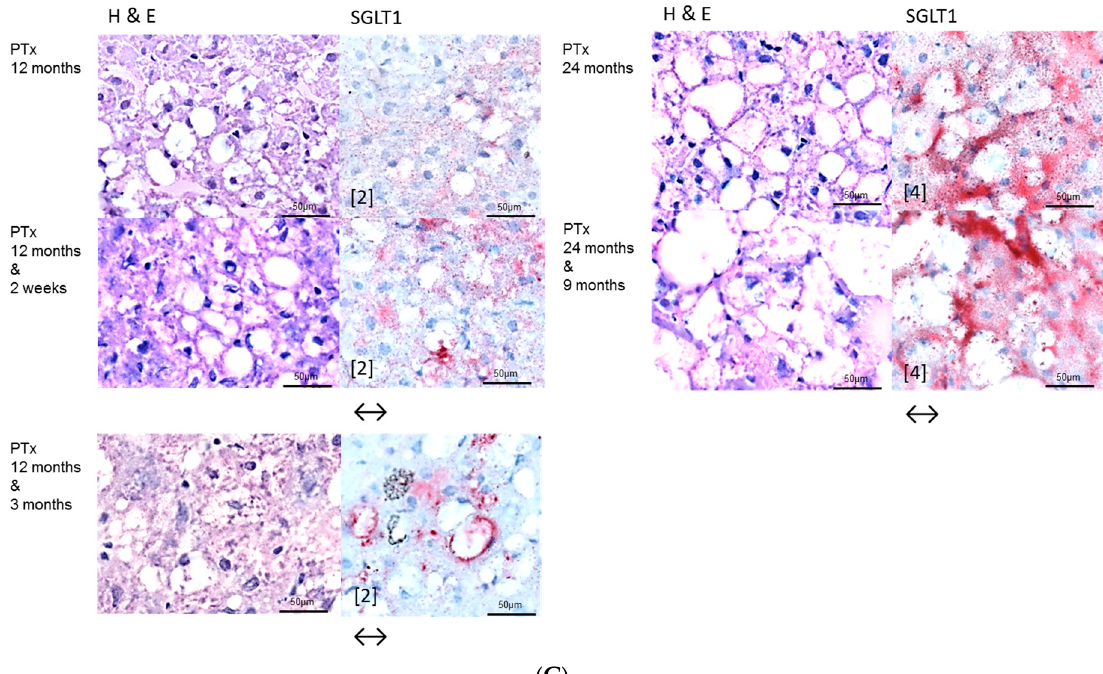
Figure 2. Effects of Gefitinib after intraportal transplantation of pancreatic islets in diabetic rats (PTx) and expression patterns of EGFR, TGF α , downstream signaling pathways and the glucose transporter protein Sodium-glucose cotransporter 1 (SGLT1) in pre-neoplastic foci of altered hepatocytes (FAH) and neoplastic liver lesions. Gefitinib was administered daily for two weeks (20 mg/kg body weight) or nine months (10 mg/kg), respectively. ( A ) Short-term experiments (three weeks and six months). FAH (dashed lines) of untreated rats (PTx 3 weeks and 6 months) at the downstream level of transplanted islets (*) with glycogen storage (PAS) with a slight overexpression of EGFR and TGF α . After Gefitinib treatment for two weeks (PTx 3 weeks & 2 weeks), only TGF α is upregulated. Nevertheless, downstream signaling with representative p-mTOR, p-4EBP1, Ras, and PanERK is downregulated corresponding to less proliferative activity after Gefitinib administration. By contrast, at six months (PTx (6 months & 2 weeks)/(6 months & 3 months)), signaling is upregulated or not altered respectively, suggesting resistance to Gefitinib; ( B ) Long-term experiments (12 and 24 months). After 12 months, expression levels of EGFR or TGF α are higher in FAH (dashed lines, with islets (*)) after Gefitinib treatment in comparison to untreated rats. After 24 months, hepatocellular carcinomas with overexpression of EGFR and TGF α , which is almost not reduced after Gefitinib treatment; ( C ) The SGLT1 glucose transporter is expressed in FAH of untreated PTx rats. There is no difference after Gefitinib treatment. Immunostaining scores are shown in brackets. Arrows correspond to ↑ upregulation, ↓ downregulation or ↔ unchanged expression level. Expression levels of immunostaining are given in brackets. Magnification: ( A ) 3 weeks/(3 weeks & 2 weeks) (H & E and PAS) 40×; marked area in dashed lines (immunostainings) 400×; 6 months/(6 months & 2 weeks)/(6 months & 3 months) (H & E, PAS) 200×; marked areal in dashed line (immunostainings) 400×; ( B ) 12 months/(12 months & 2 weeks) (H & E and PAS) 60×; marked area in dashed line (immunostainings) 400×; 24 months/(24 months & 9 months) overview 20×; marked area in dashed lines (H & E and immunostainings) 400×; ( C ) (H & E and SGLT1) 400×.